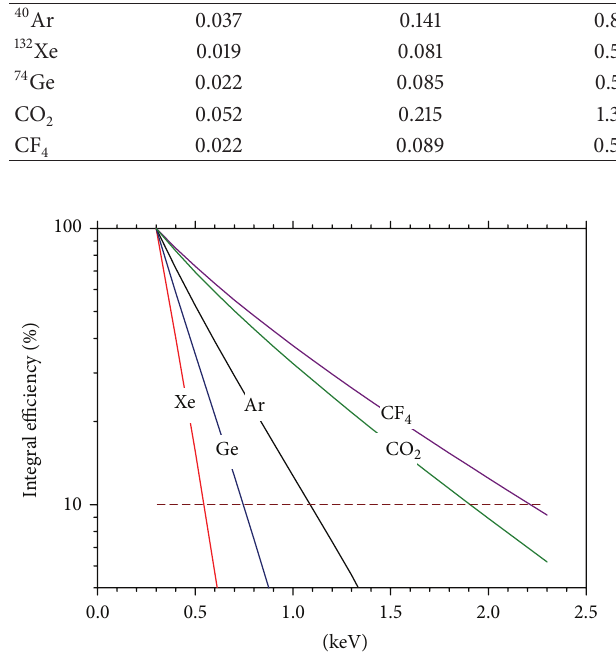
Figure 9: The integral efficiency of counting as a function of a